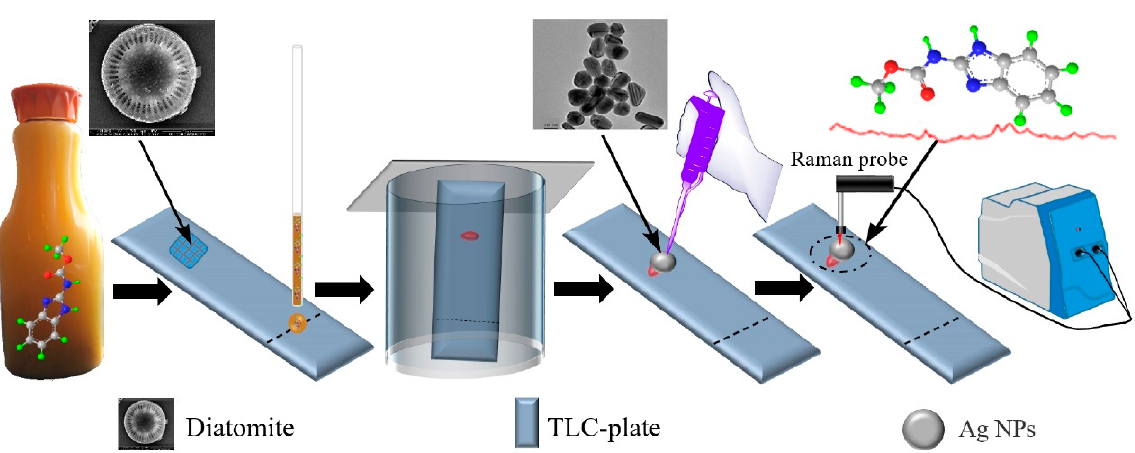
Figure 4. TLC-SERS detection of pesticide residue from food sample. Reprinted with permission from ref. [73]; Copyright 2021 Elsevier. from ref. [73]; Copyright 2021